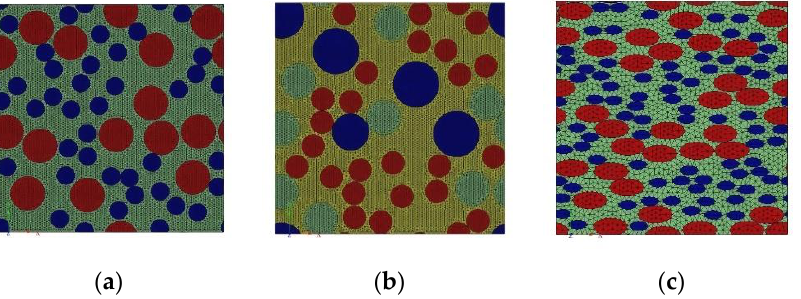
Figure 5. Representative volume unit (RVE) finite element model with different particle shapes and gradations. ( a ) Two grades and round particles, ( b ) three grades and round particles, and ( c ) two grades and oval particles. Table 3. Effective elastic modulus of different shapes and gradations.